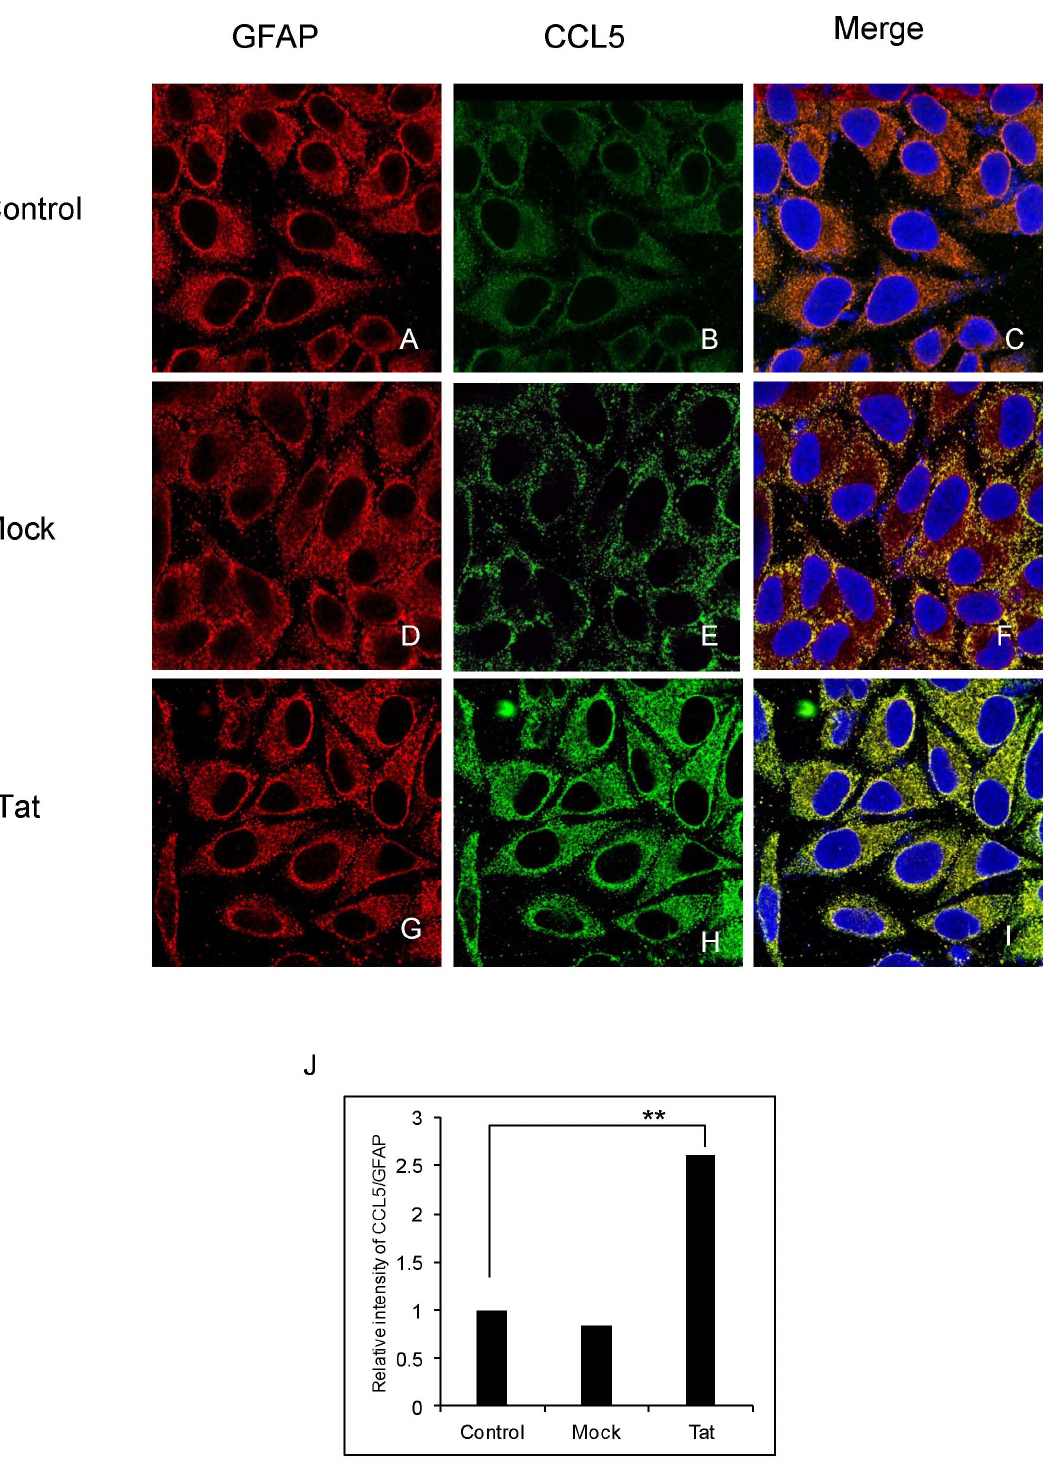
Figure 2. Immunocytochemistry of CCL5 induced by HIV-1 Tat in astrocytes. (A–I) SVGA astrocytes were grown on a cover slip before transfecting with HIV-1 Tat plasmid. Untransfected control (A–C) and mock-transfected cells (D–F) were used to compare the up-regulation of CCL5 in cells transfected with HIV-1 Tat (G–I). The cells were stained with the primary antibodies against CCL5 and GFAP and secondary antibody labeled with Alexafluor 555 (GFAP) and Alexafluor 488 (CCL5). Finally the cover slips were mounted on medium containing DAPI to stain the nucleus. The merge panels represent the co-localization of CCL5 with GFAP. The images were captured using inverted confocal microscope, Leica TCS SP5 II. (J) The intensity of CCL5 over GFAP was calculated using imageJ software. Student’s t-test was employed to calculate the significance and ** denotes the p- value # 0.01.